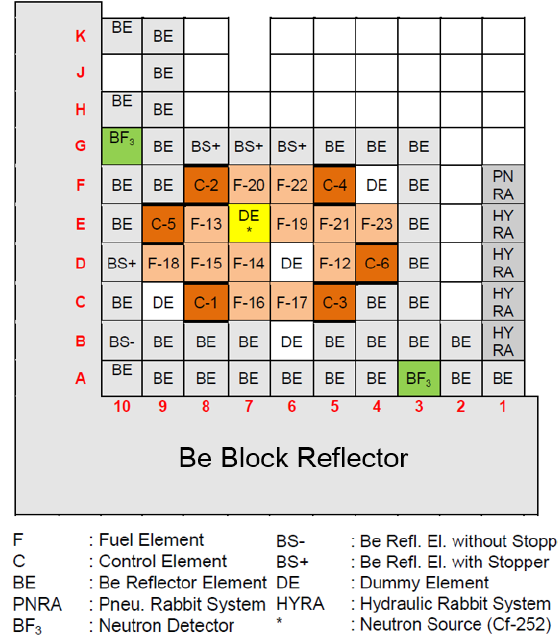
Figure 2. Full core configuration of RSG GAS first core [3]